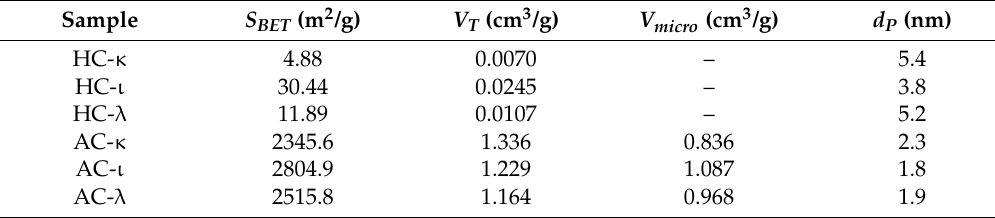
Table 2. Textural properties of the hydrochars and activated carbons.